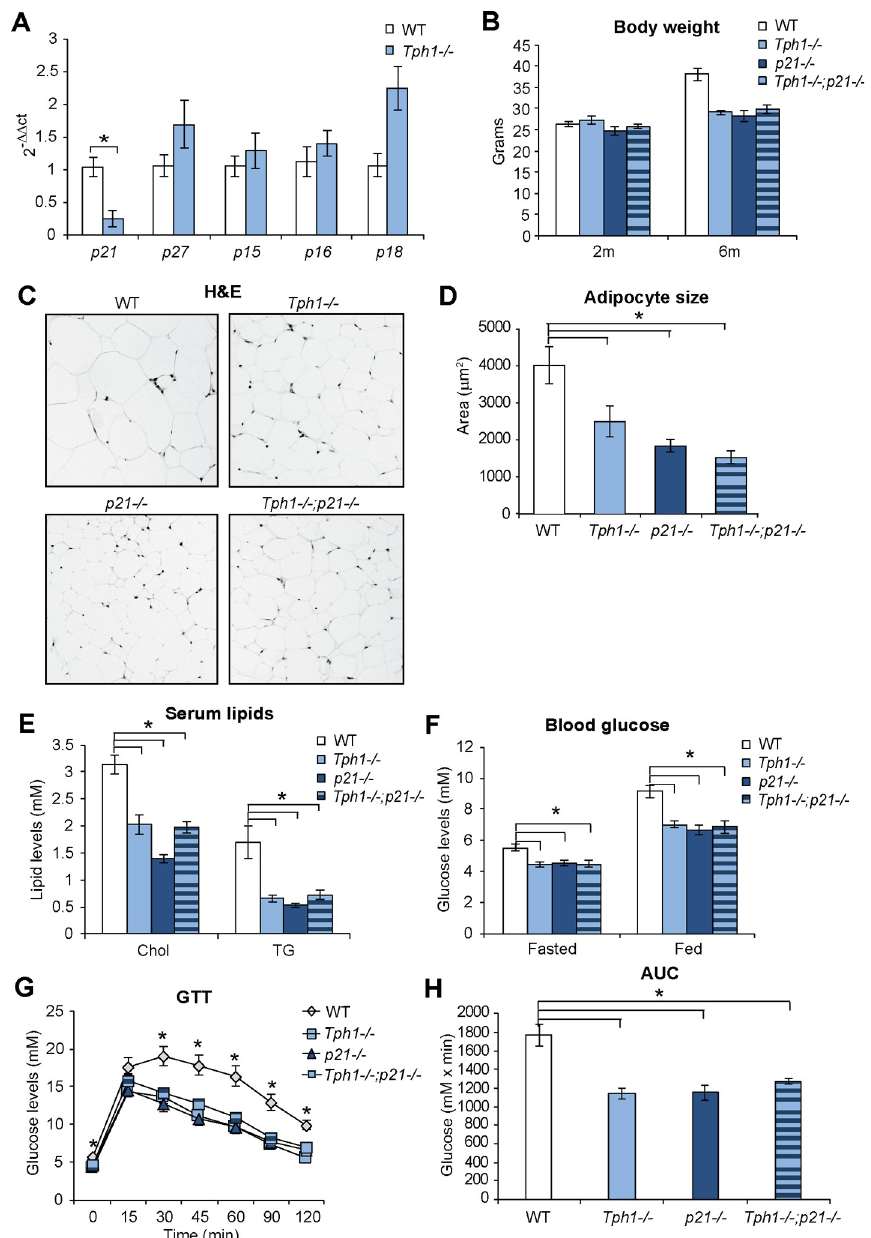
Fig 4. Early adulthood metabolic changes are reduced in the absence of p21 . (A) qPCR of cell cycle inhibitors in epididymal fat in 6 months old wild type (WT) and Tph1 deficient ( Tph1 -/- ) mice. (B) Quantification of body weight of WT, Tph1 -/- , p21 deficient ( p21 -/- ) and Tph1 , p21 double deficient ( Tph1 -/- ; p21 -/- ) mice at 2 and 6 months of age. (C) Haematoxylin and Eosin (H&E) staining of epididymal fat in WT, Tph1 -/- , p21 -/- and Tph1 -/- ; p21 -/- mice at 6 months of age. (D) Quantification of adipocyte size in epididymal fat in 6 months old mice. (E) Quantification of blood cholesterol (Chol) and triglyceride (TG) levels in WT, Tph1 -/- , p21 -/- and Tph1 -/- ; p21 -/- mice at 6 months of age. (F) Blood glucose levels in WT, Tph1 -/- , p21 -/- and Tph1 -/- ; p21 -/- mice at 6 months of age in fasted and fed state. (G) Glucose tolerance test (GTT) in WT, Tph1 -/- , p21 -/- and Tph1 -/- ; p21 -/- mice at 6 months of age. (H) Area under the curve (AUC) of GTT in WT, Tph1 -/- , p21 -/- and Tph1 -/- ; p21 -/- mice at 6 months of age.Results are average ± SEM (n � 5), � p < 0.05.